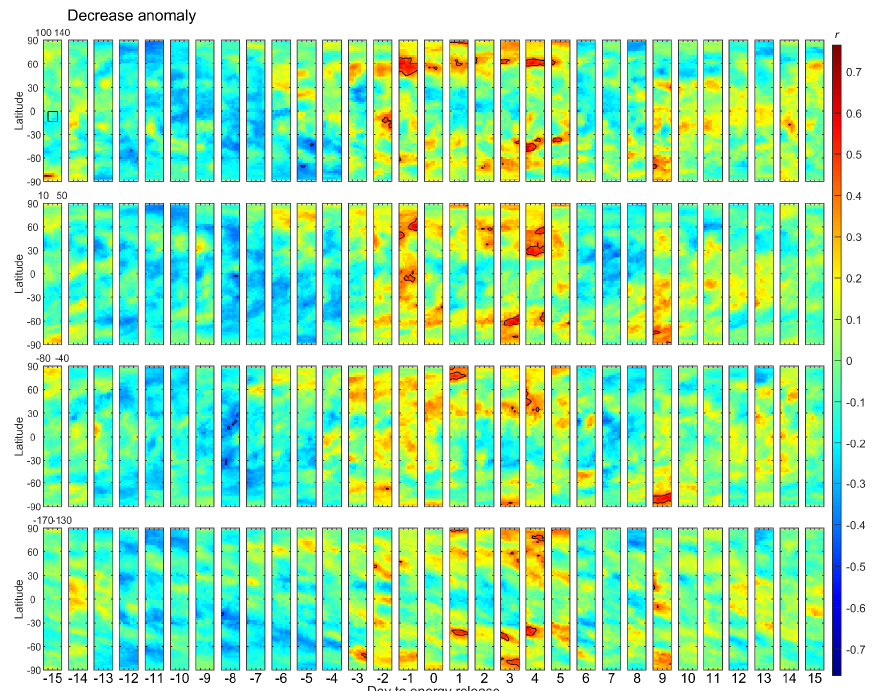
Figure 7. Same as Figure 5 for the daily seismic wave energy release ≥ M 5.5 without outliers within Region A and for the TEC decrease anomalies. The contour denotes r α = 0.01 according to sample size at each D.